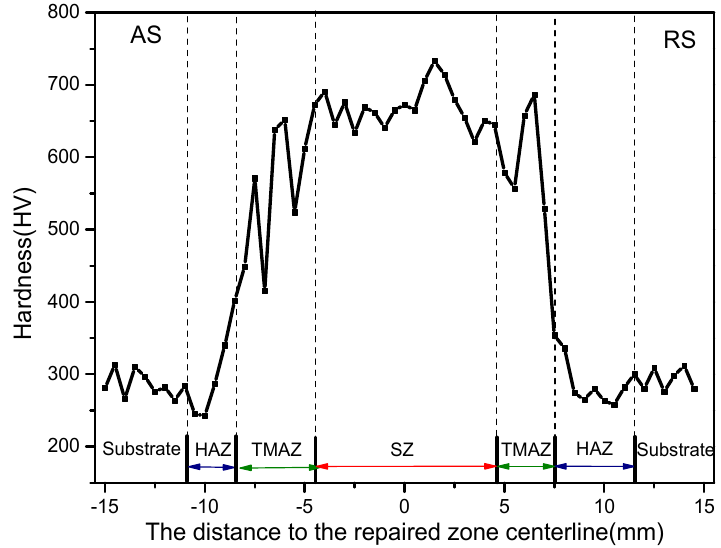
Figure 9. Microhardness distribution for FSP-repaired 34CrNiMo6. HAZ, heat-affected zone, TMAZ, thermo-mechanically affected zone.